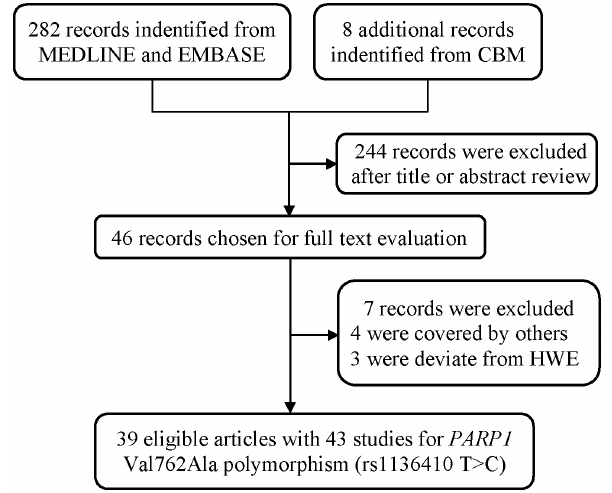
Figure 1. Flow diagram of included studies for the association between PARP1 Val762Ala polymorphism.